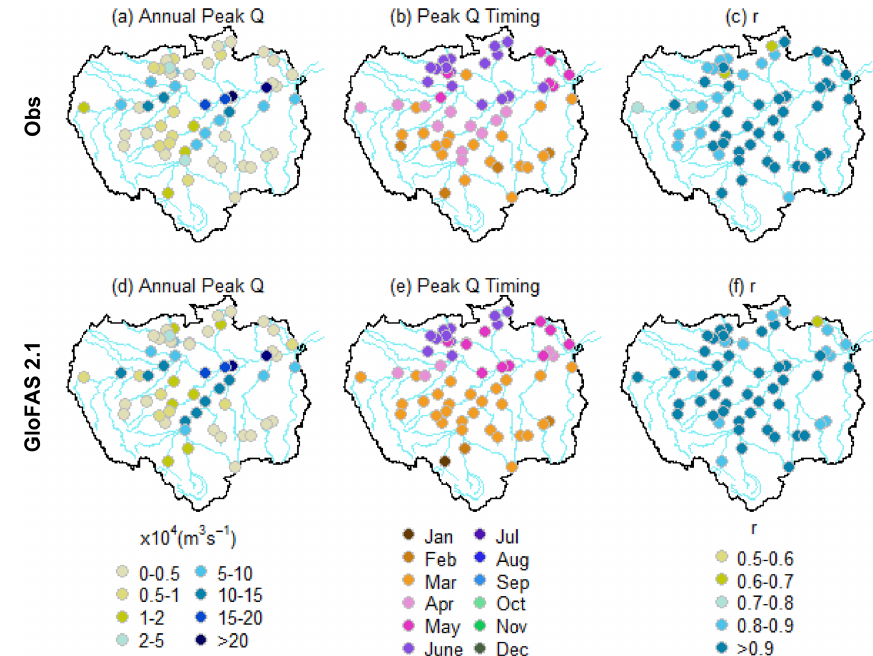
Figure 1. 36-year climatology of observed (a–c) and GloFAS 2.1 streamflow reanalysis (d–f) datasets (1979–2015). (a, d) Mean annual maximum river flows. (b, e) Average timing of peak flow occurrences. (c, f) Interannual variability of peak flow timing (i.e. the consistency of when rivers reach their peaks. Values closer to 1 mean that rivers reach their peak at a similar time each hydrological year, whereas values closer to zero reflect a highly variable regime where flood peaks are spread through the